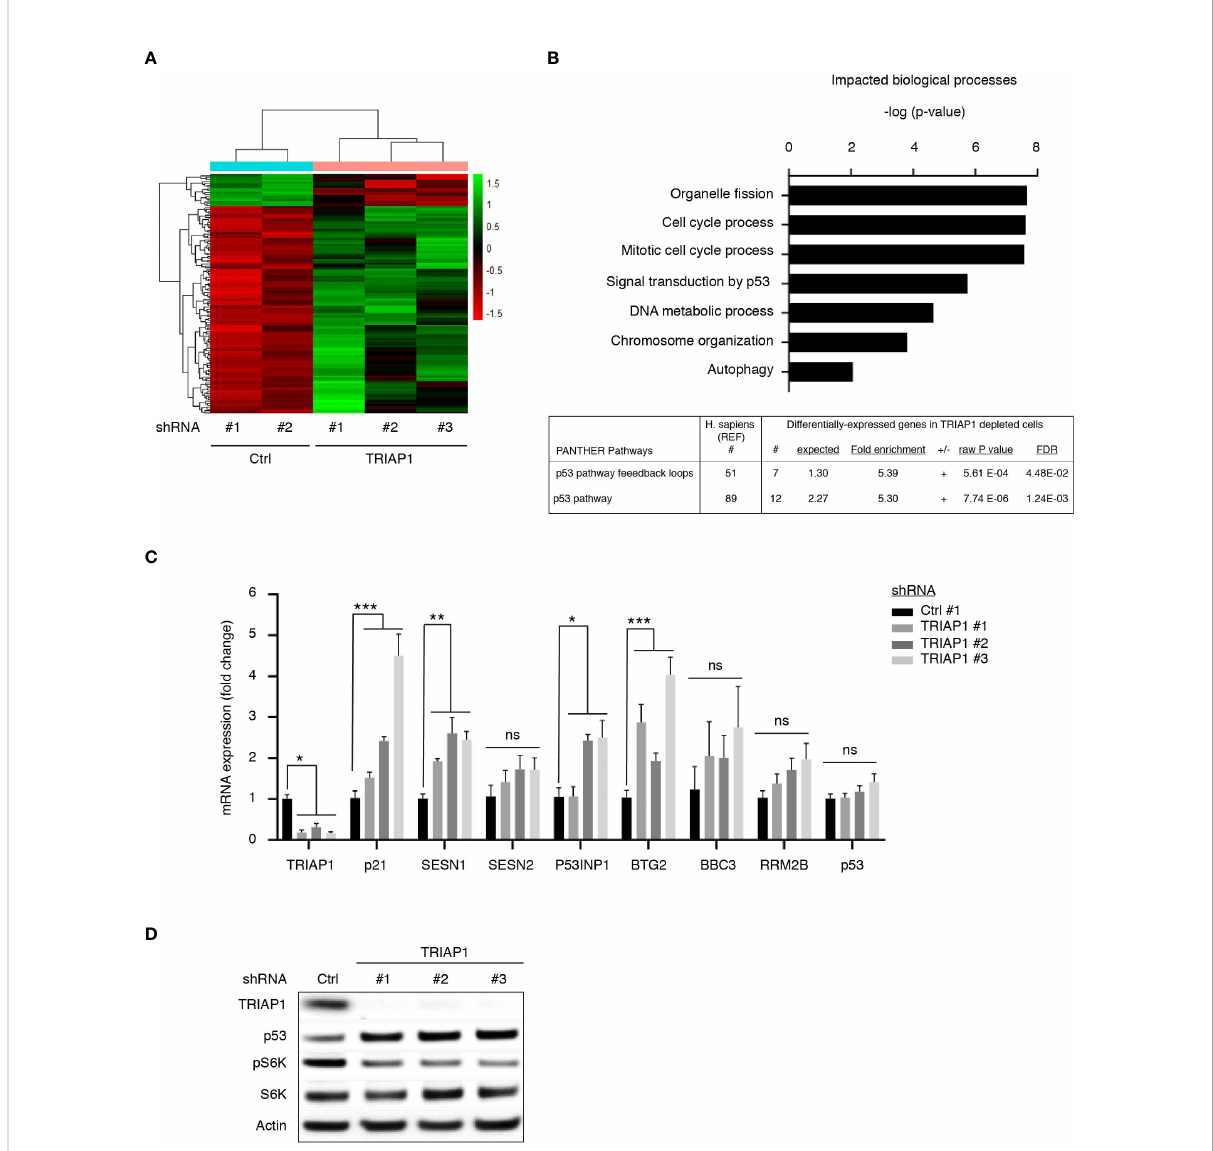
FIGURE 5 TRIAP1 depletion activates a p53-related stress response. (A) Transcriptomics analysis of HCT116 cells transduced with control (ctrl#1, #2) and TRIAP1 (TRIAP1 #1, #2, #3) shRNAs. Heat map and hierarchical clustering based on genes that are differentially expressed between TRIAP1- depleted (shRNA TRIAP1 #1, #2, #3) and control (shRNA Ctrl #1, #2) cells analyzed by RNA-seq, 6 days post transduction (adjusted p value < 0.05). Genes are listed by row and analyzed samples by column. The color intensity represents the Z score, where green corresponds to upregulated and red downregulated expression. (B) Top enriched biological processes (top panel). The differentially expressed genes were analyzed for Gene Ontology (GO) using the “ ToppGene Suite ” (40). The top GO terms for biological processes are represented with a bar plot with most signi fi cant p-values (Adj. p value <0.07). Top enriched signaling and functional pathways (bottom panel). Signi fi cantly enriched pathway term analysis for differentially expressed genes in relation to TRIAP1 depletion was carried out using the online PANTHER website (55). (C) mRNA expression analyses of several P53 target genes identi fi ed as differentially expressed during transcriptomics studies performed in (A) qPCR studies were realized for the indicated mRNA. Relative expression fold variation was calculated for TRIAP1-depleted cells (shRNA TRIAP1 #1, #2, #3) compared with control (shRNA Ctrl) cells, using the comparative Ct method (after normalization against actin mRNA). Data represent mean ± SEM of three experiments. Kruskal – Wallis tests were used for statistical comparisons. *p < 0.05; **p < 0.01; ***p < 0.001; ns, non signi fi cant. (D) Immunoblot analysis of extracts of HCT116 cells transduced with lentiviral control (Ctrl) and TRIAP1 (TRIAP1 #1, #2, #3) shRNAs and grown in standard growth conditions. Actin was used as a loading